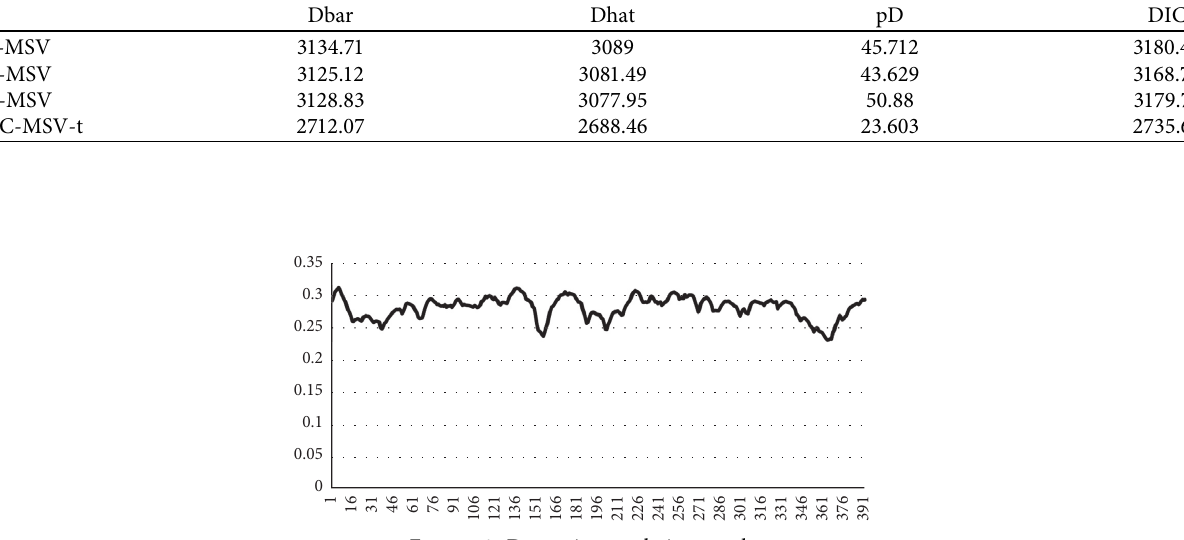
Table 3: DIC result of CC-MSV, GC-MSV, DC-MSV, and